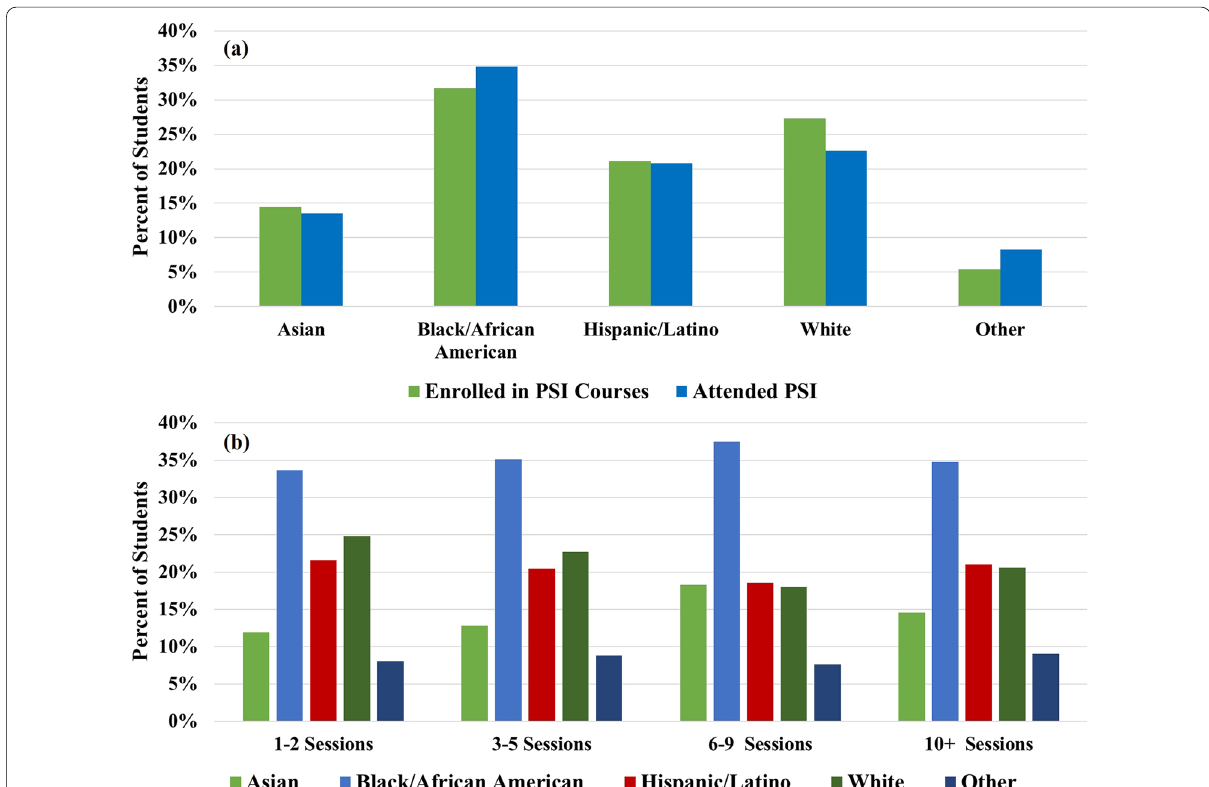
Fig. 2 a Self‑identified racial/ethnic demographic distribution of students enrolled in PSI‑supported courses vs. students attending PSI sessions. b Self‑identified racial/ethnic demographic distribution of students attending PSI sessions, separated by frequency of attendance (1–2, 3–5, 6–9, or 10 PSI sessions for a given course within a single +